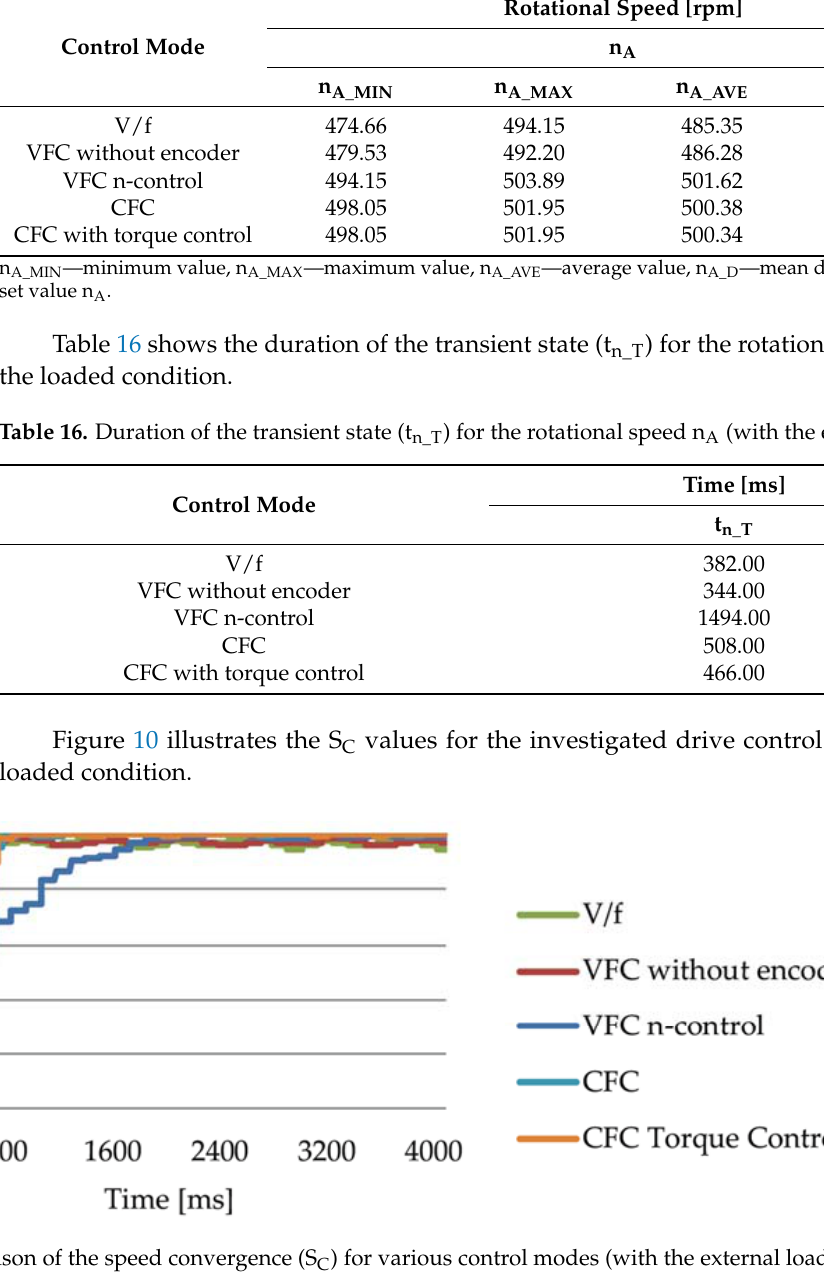
Table 15. Characteristics of the rotational speed n A in the steady state (with the external load).